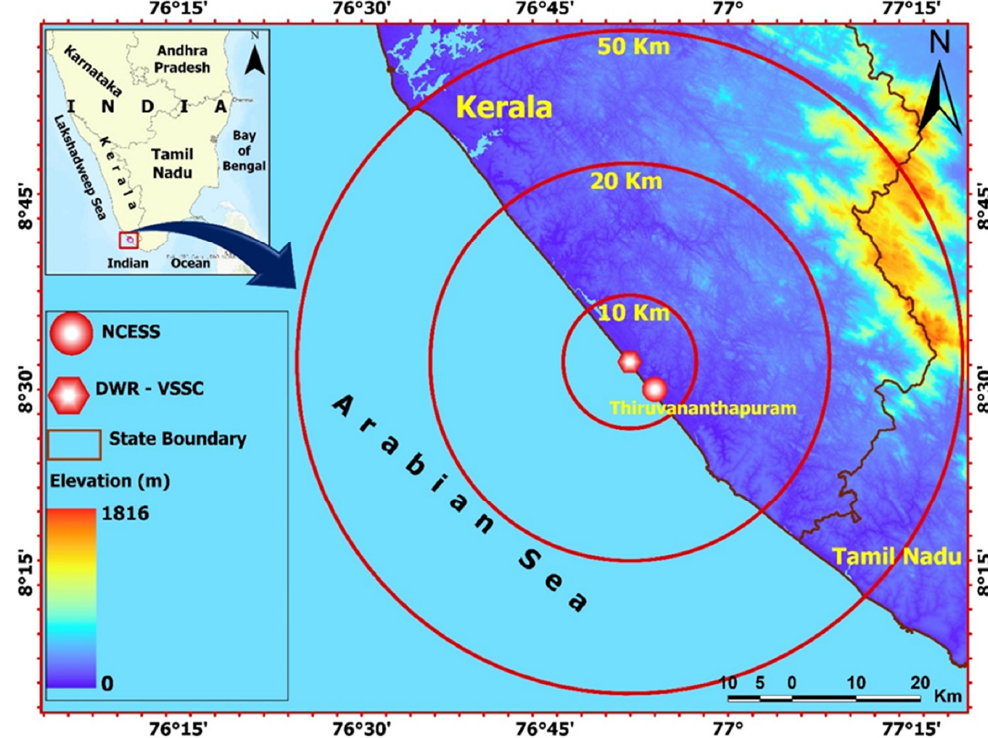
Figure 1. Terrain height (m) over the study area and the locations of the C-band DWR and NCESS observatory are given. Concentric circles represent distance from the radar.